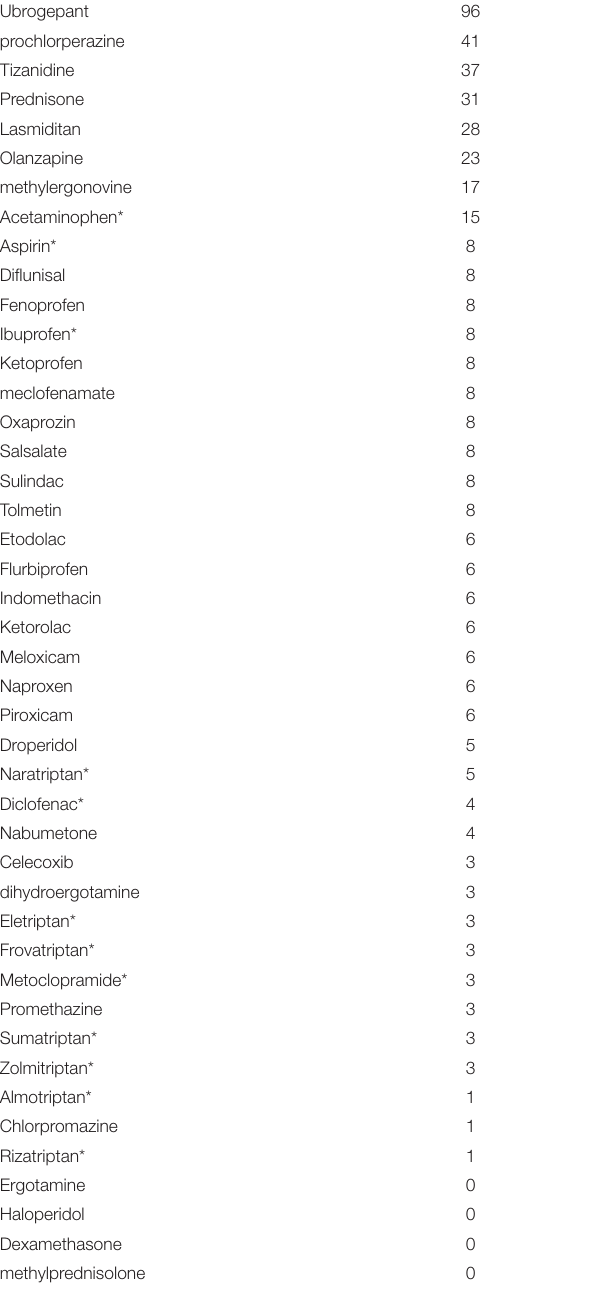
TABLE 1 | List of abortives included and number of